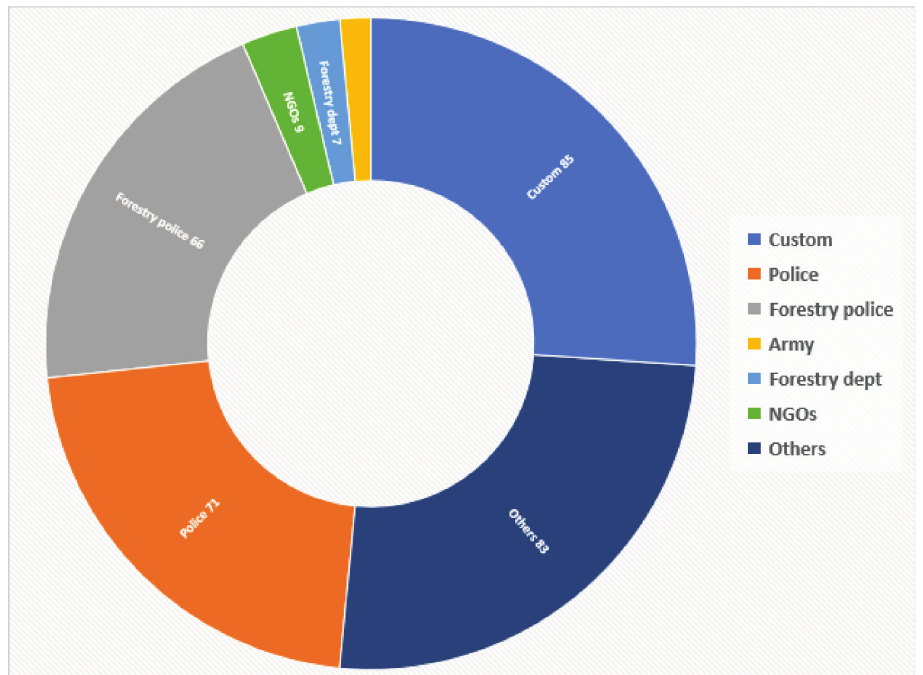
Figure 4. Agencies involved in Arresting of Pangolins traffickers and